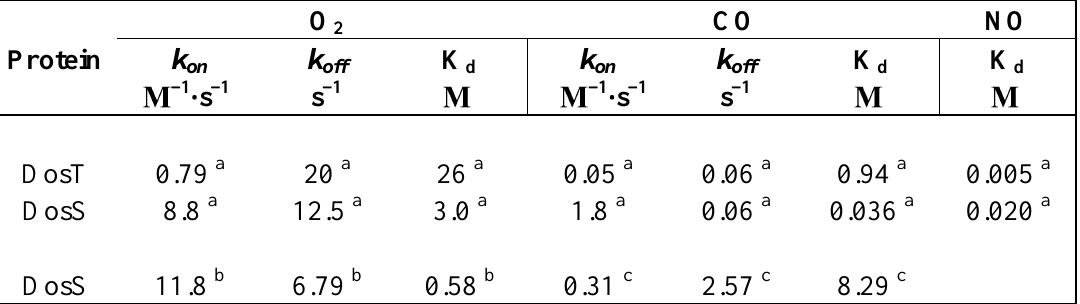
Table 3. Equilibrium and kinetic values for DosS and